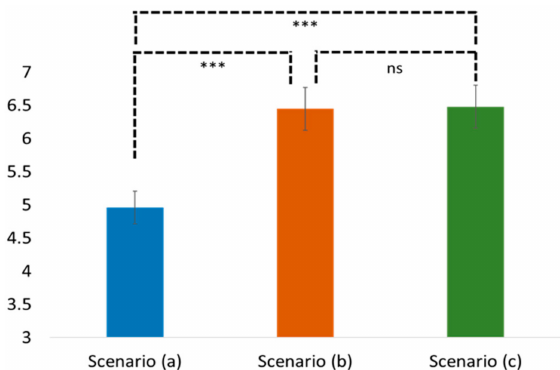
Figure 4. Comparisonoftheperceivedself-efficacyindifferentscenarios. Note: nsstandsfornon-significant; *** means < 0.01.